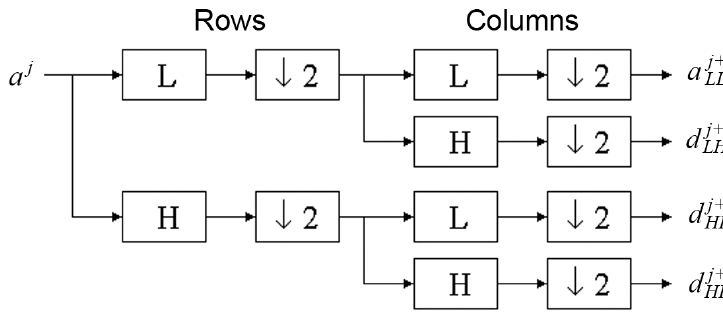
Figure 4. Wavelet decomposition for two-dimensional photography.